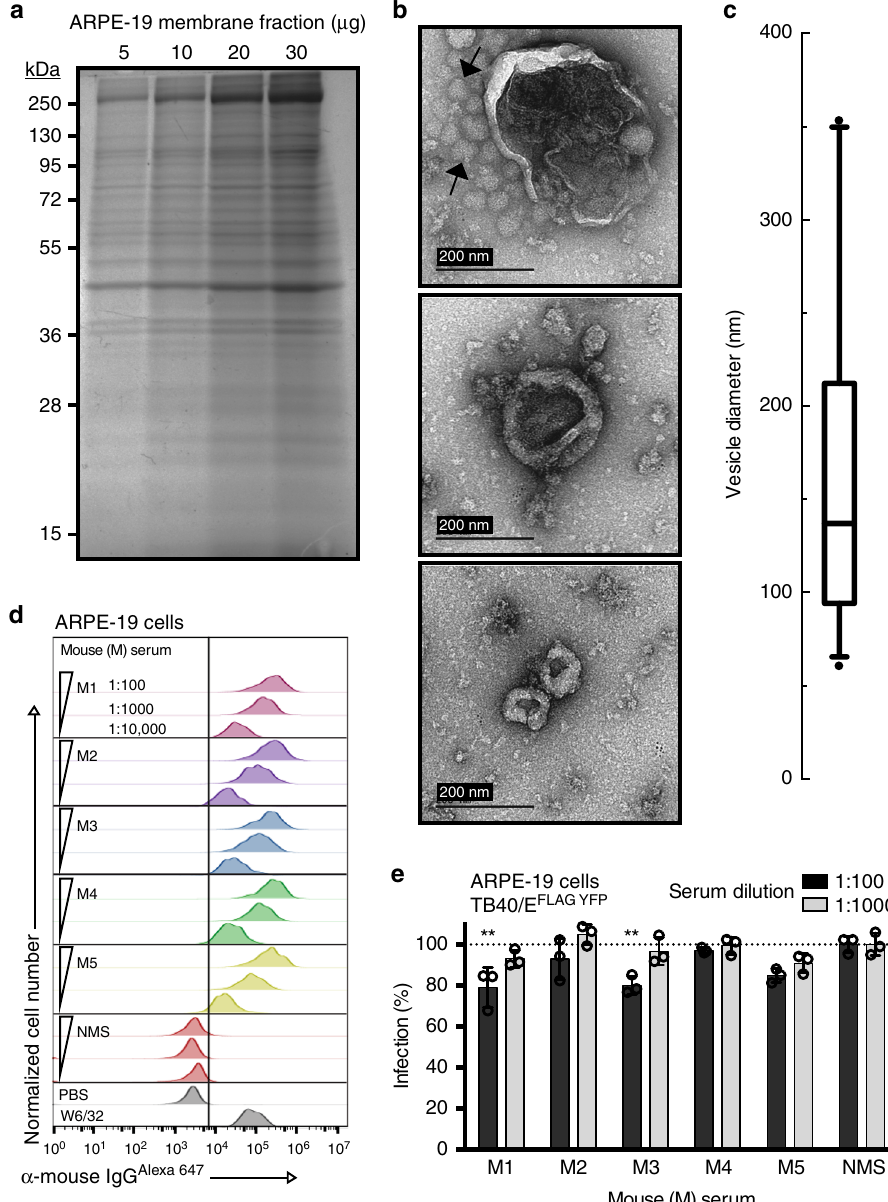
Fig. 1 Physical attributes of ARPE-19 cell-derived vesicles and their humoral immune response in mice. a Increasing amounts of ARPE-19 membrane fraction ( μ g) were resolved on a SDS-polyacrylamide gel (12.5%) and visualized using Gel Code Blue Reagent (ThermoFisher Scienti fi c). b Transmission electron microscopy (TEM) images of the membrane fraction. Representative images demonstrate the range in vesicle sizes within the fraction. Arrows indicate observed protein aggregates surrounding vesicles. c The distribution of vesicle diameters (nm) ( n = 29). Bounds of the box span 25 – 75% percentile, the center line represents median, and whickers visualize 5 and 95% of the data points. d Dilutions of serum from fi ve mice (M1 – M5) immunized with the ARPE-19 membrane fractions were subjected to fl ow cytometry with ARPE-19 cells. Normal mouse serum (NMS), PBS, and the mAb W6/32 (targeting MHC class I) were used as controls. e Two dilutions of serum from the ARPE-19 vesicle immunized mice were subjected to a high- throughput infectivity assay (HTI) with TB40/E FLAG YFP infection of ARPE-19 cells using YFP fl uorescence as readout for infection. The % infection was determined using virus incubated with normal mouse serum (NMS) as 100%. Infection data was performed in triplicate. s.d. is depicted in the experiment. ** P < 0.01(Student ’ s two-tailed t